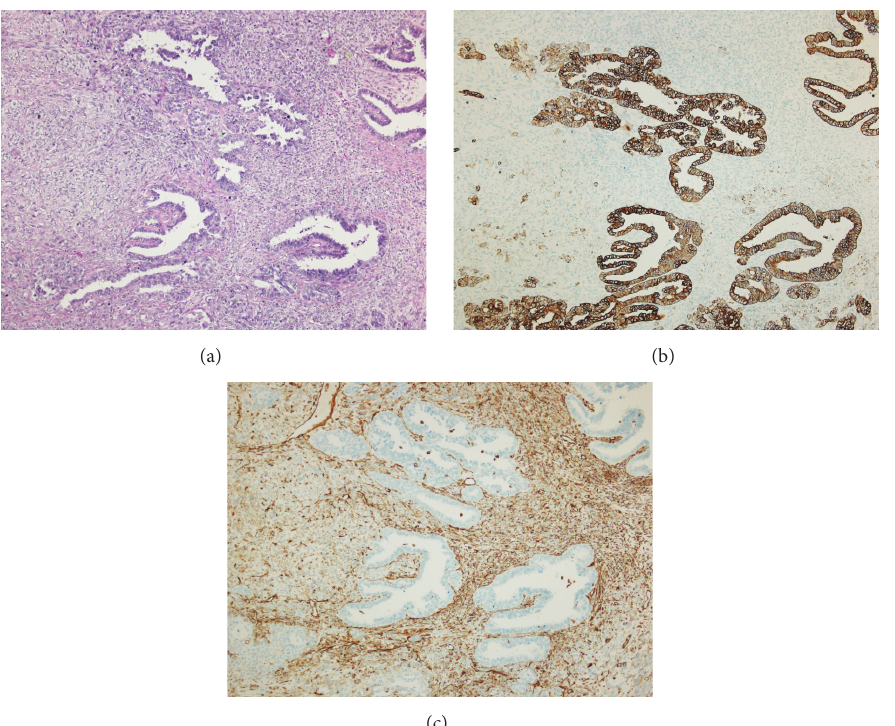
Figure 2: (a) Left ovary: carcinosarcoma consists of glands with complex papillary embedded in a solid sarcomatoid proliferation (hematoxylin and eosin, 100x). (b) Left ovary: the epithelial component displays strong reactivity indicating cytokeratin (AE1/AE3) (100x). (c) Left ovary: the sarcomatoid cell population illustrates focal staining for vimentin, while most of the epithelial component showed negative results (100x).